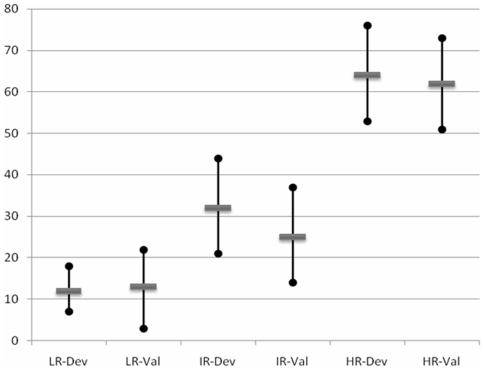
90-day-mortality-rates and 95%-confidence intervals according to the predicitve score.LR-Dev: Low-risk patients among the developpement cohort (score = [0–1]). LR-Val: Low-risk patients among the validation cohort (score = [0–1]). IR-Dev: Intermediate-risk patients among the developpement cohort (score = 2). IR-Val: Intermediate-risk patients among the validation cohort (score = 2). HR-Dev: High-risk patients among the developpement cohort (score = [3–4]). HR-Val: High-risk patients among the validation cohort (score = [3–4]).